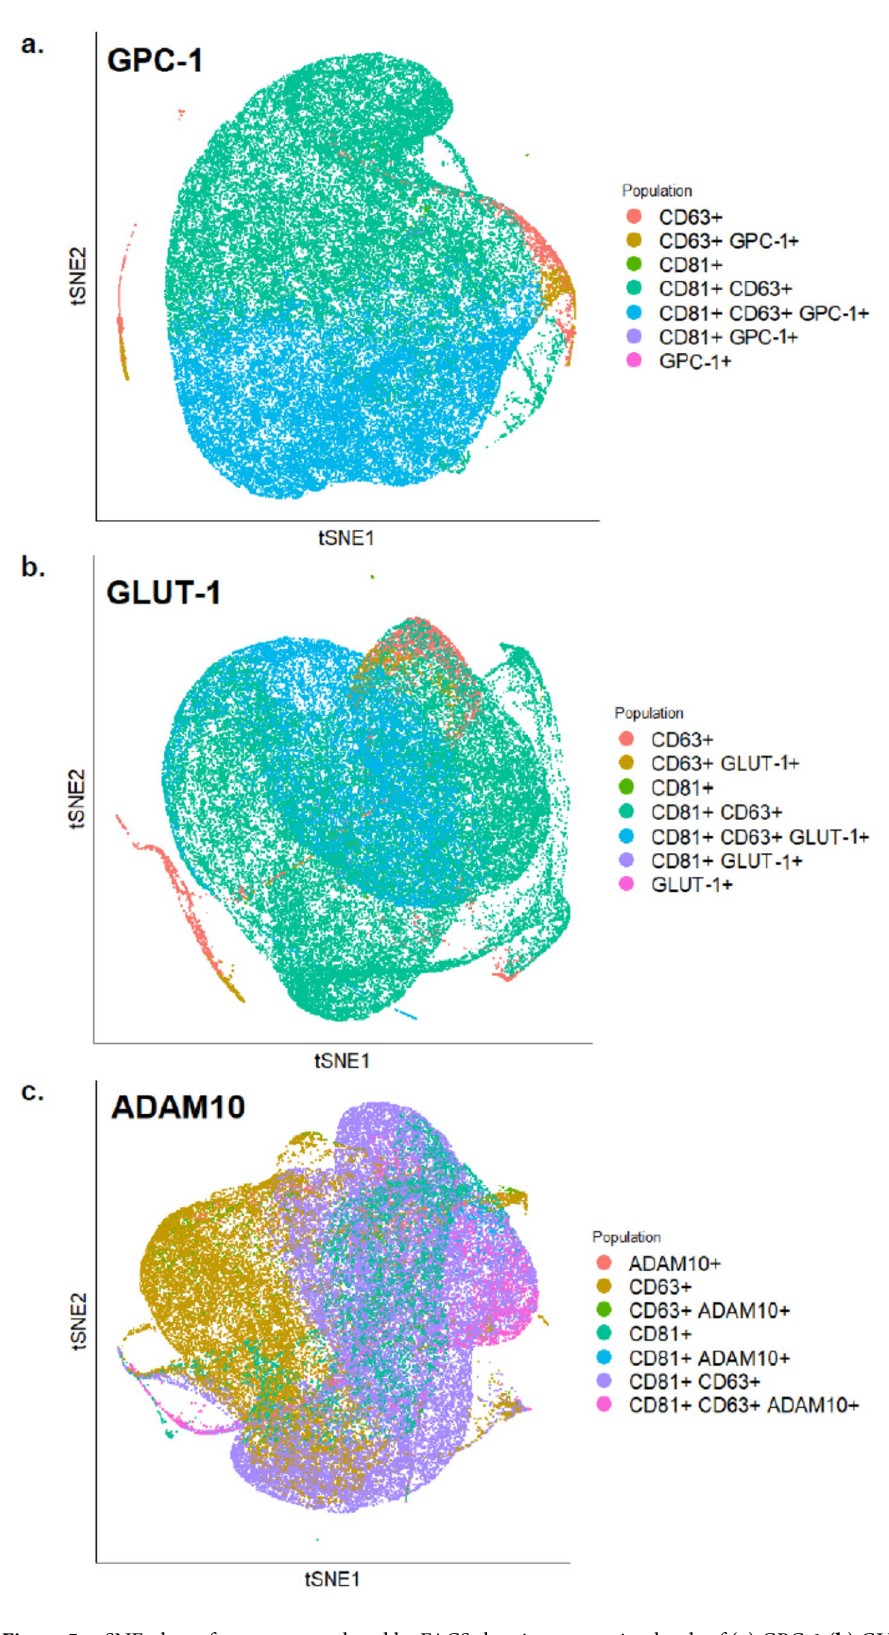
Figure 5. tSNE plots of exosomes analyzed by FACS showing expression levels of ( a ) GPC-1 ( b ) GLUT-1 and ( c ) ADAM10 along with CD81 and CD63 on the surface of BC-derived